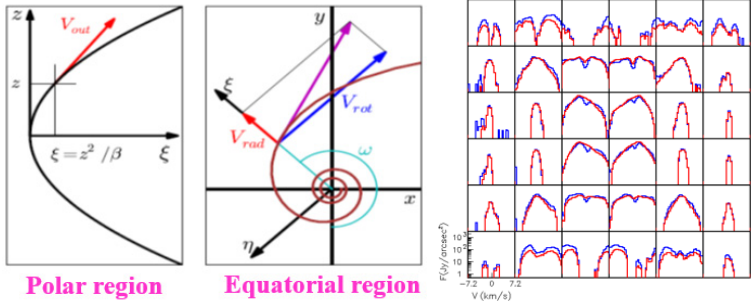
Fig. 4 Red Rectangle. Left and centre: gas velocity and trajectories. Right: Doppler velocity spectra comparing data (blue) and model (red).